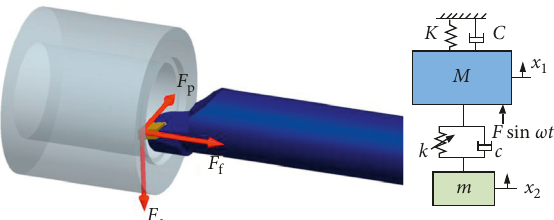
Figure 2: Dynamic model of the boring bar with a variable stiffness